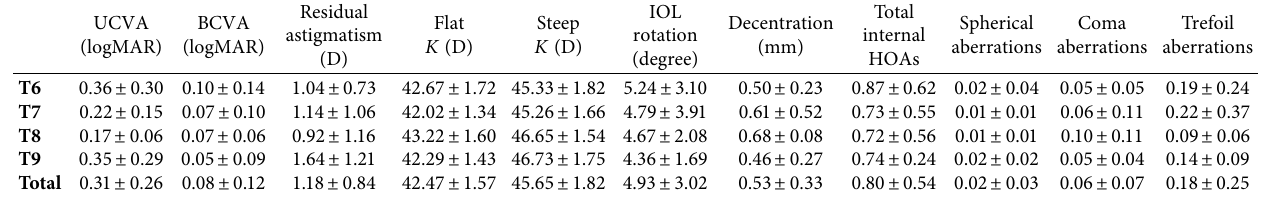
Table 2: Outcome analysis after cataract surgery with a high-power toric intraocular lens.